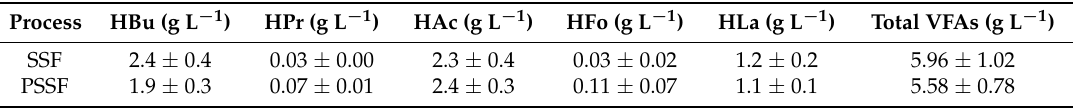
Table 2. Soluble metabolite products in the hydrogenic effluents of the SSF and PSSF experiments using a biomass concentration of 20 g L − 1